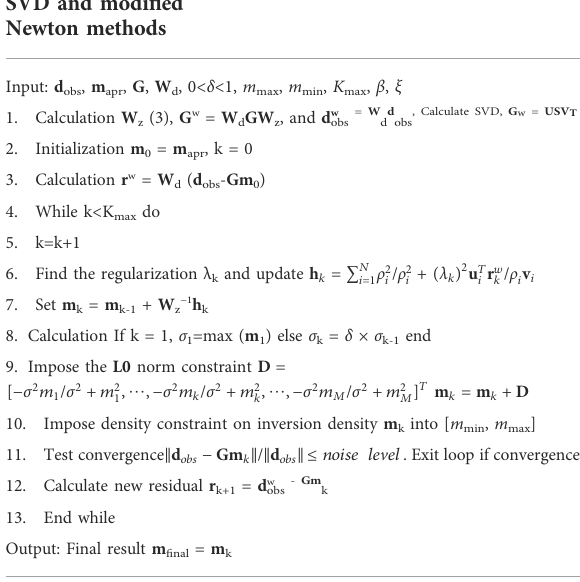
TABLE 2 Sparsity gravity inversion based on the Lanczos bidiagonalization compression algorithm. Algorithm 2 sparsity gravity inversion using the iterative SVD and the modi fi ed Newton methods based on the Lanczos bidiagonalization compression